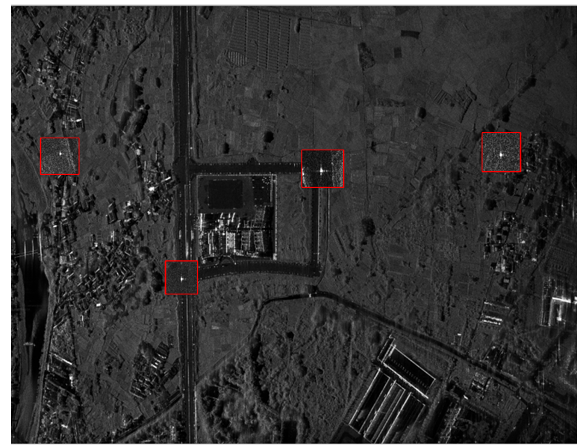
Figure 14. Processing building 2D SAR imaging.